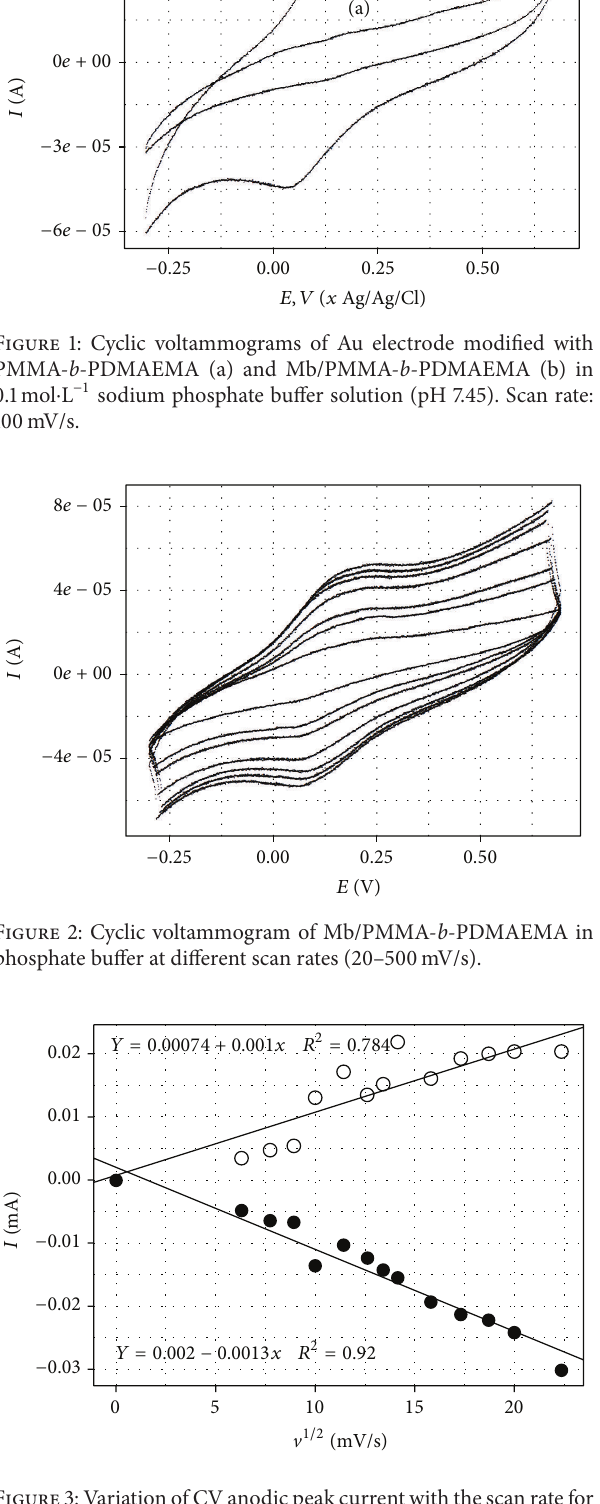
Figure 3: Variation of CV anodic peak current with the scan rate for Mb/PMMA- b -PDMAEMA in phosphate buffer. Symbols represent anodic and cathodic data: l —ip 𝑎 and e —ip 𝑐